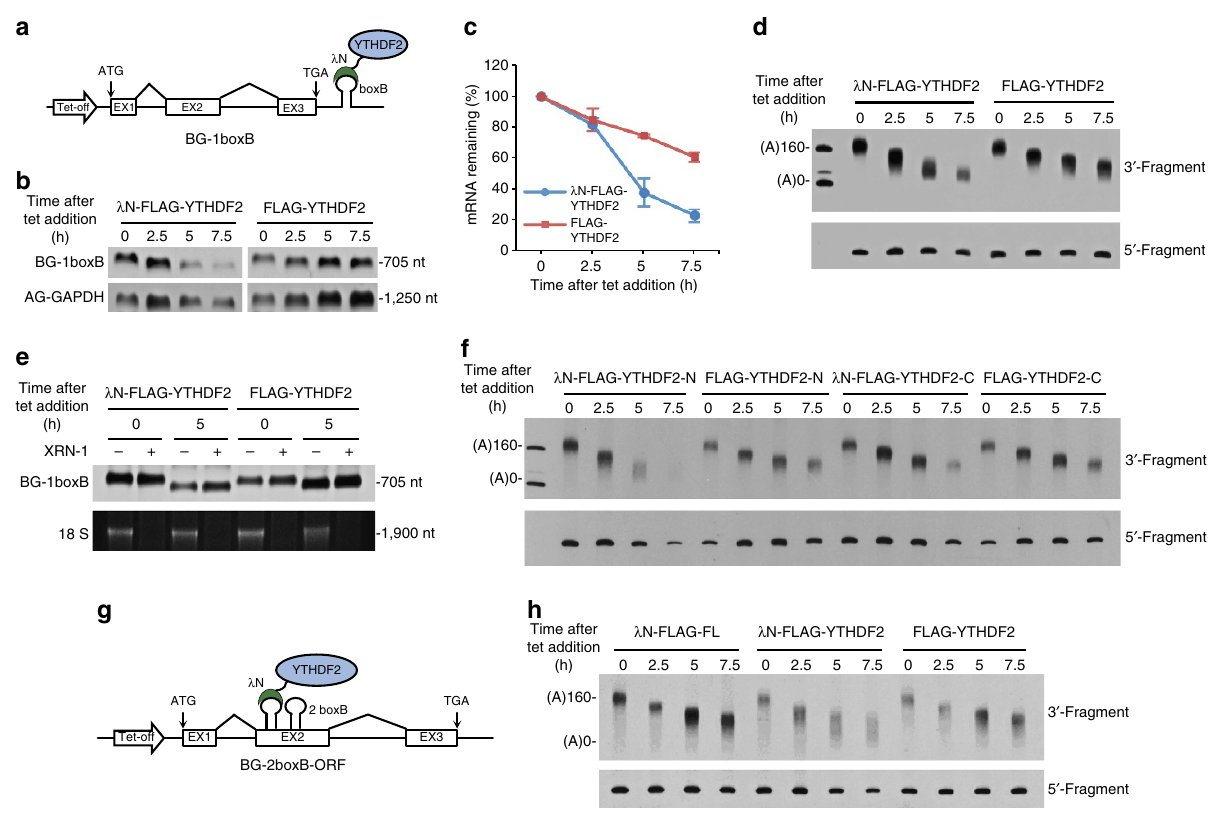
Figure 2 | YTHDF2 destabilizes mRNA by hastening deadenylation as an initial step. ( a ) Construct of BG-1boxB, which can bind to proteins fused with a l N peptide through the boxB sequence. ( b ) Decay of BG-1boxB mRNA in the presence of l N-FLAG-YTHDF2 or FLAG-YTHDF2. AG-GAPDH, a constitutively transcribed internal standard was co-transfected. ( c ) Graphs of the concentration of BG mRNA described in b as a function of time. The abundance of BG-1boxB mRNA remaining at each time point was normalized to that of AG-GAPDH. Error bars, mean ± s.d., n ¼ 3, biological replicates. ( d ) Deadenylation assay of BG-1boxB mRNA in the presence of l N-FLAG-YTHDF2 or FLAG-YTHDF2. ( e ) Retention of the 5 0 -cap on BG-1boxB mRNA in the presence of l N-FLAG-YTHDF2 or FLAG-YTHDF2. ( f ) Deadenylation assay of BG-1boxB mRNA tethered with an N-terminal P/Q/N-rich region the BG reporter. ( h ) Deadenylation assay of BG-2boxB-ORF mRNA in the presence of l N-FLAG-FL, l N-FLAG-YTHDF2 or